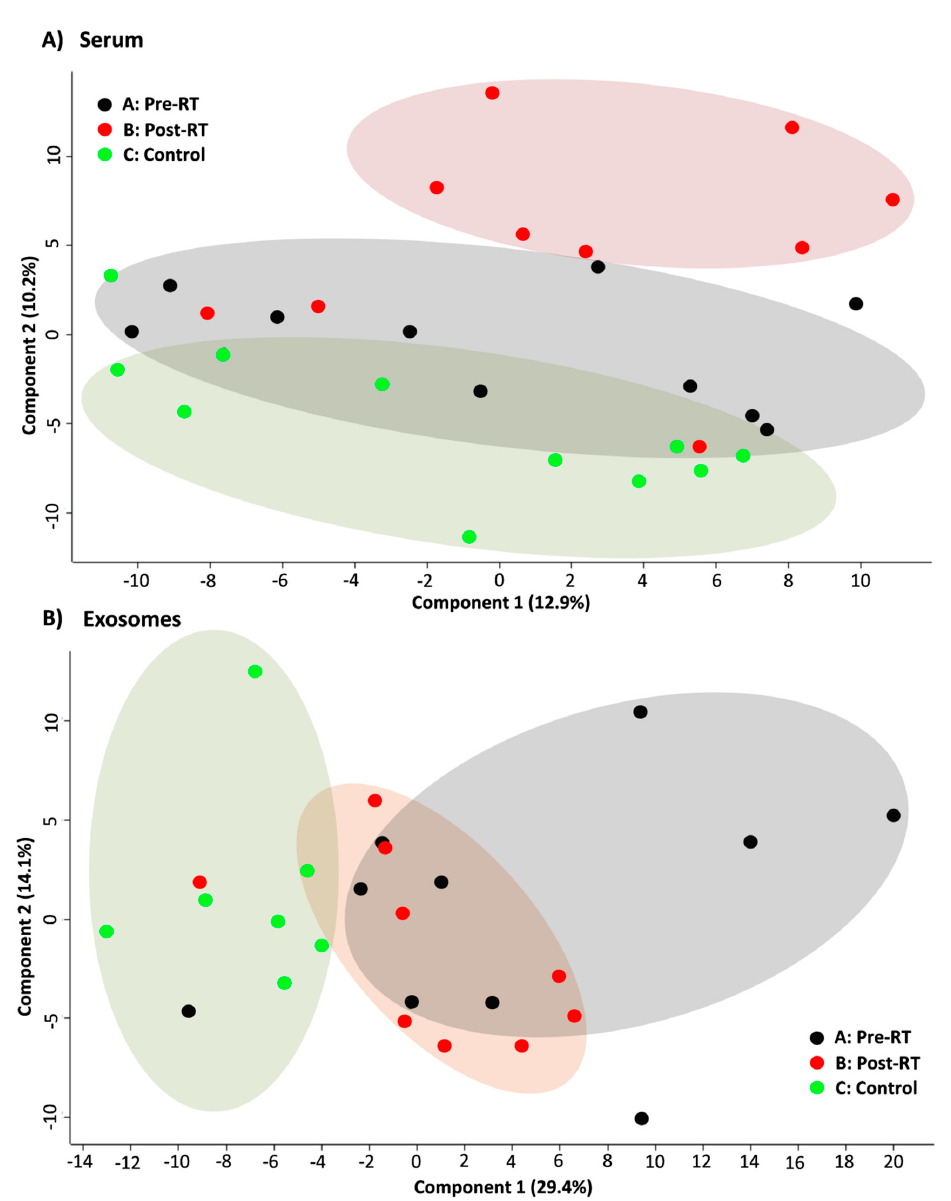
Figure 3. PCA score plots showing the clustering of cancer pre-RT samples A, cancer post-RT samples B, and control samples C. Shown are two the first components responsible for 23.1% of the variability of the serum samples (panel A ) and 43.5% of the variability for the exosome samples (panel B ).